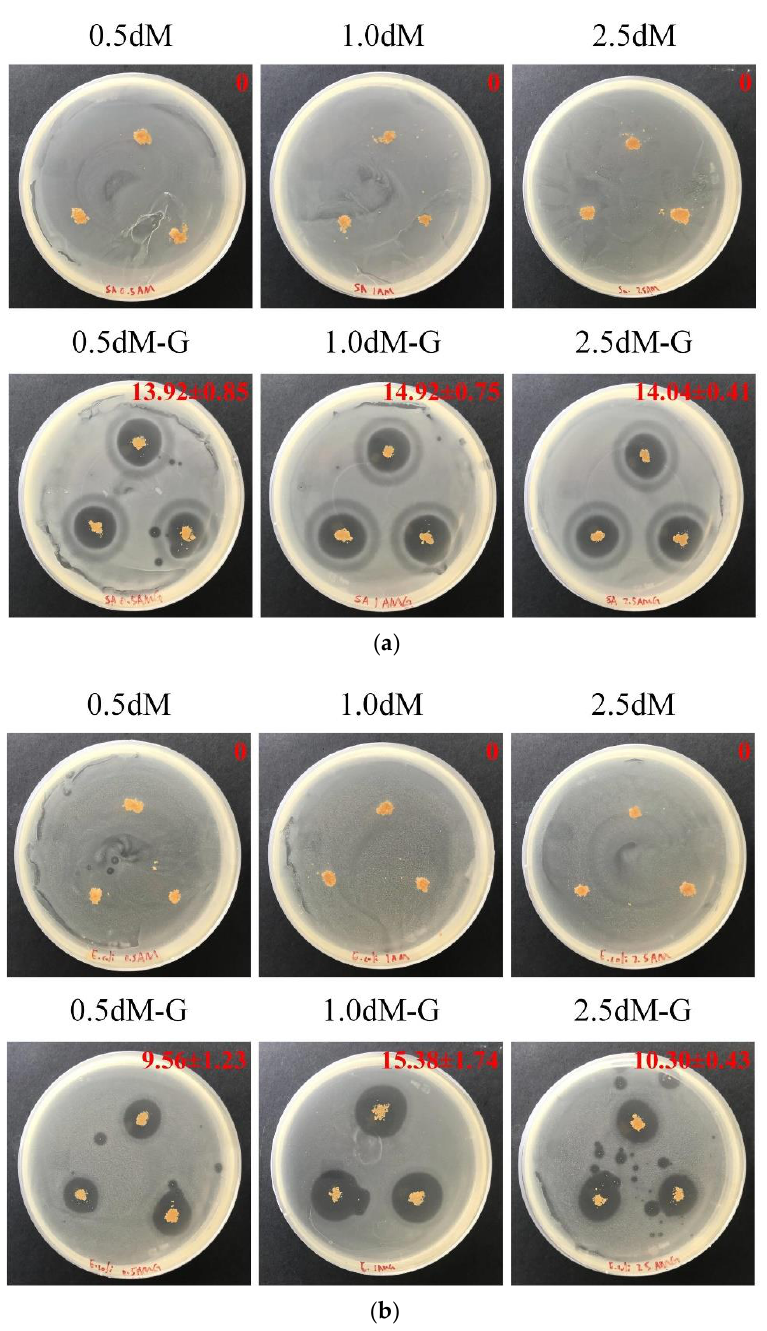
Figure 6. Antibacterial activities of antibiotic-free and DAP-modified microspheres impregnated with antibiotics against ( a ) S. aureus and ( b ) E. coli for a zone of inhibition of 1 day ( n = 3).